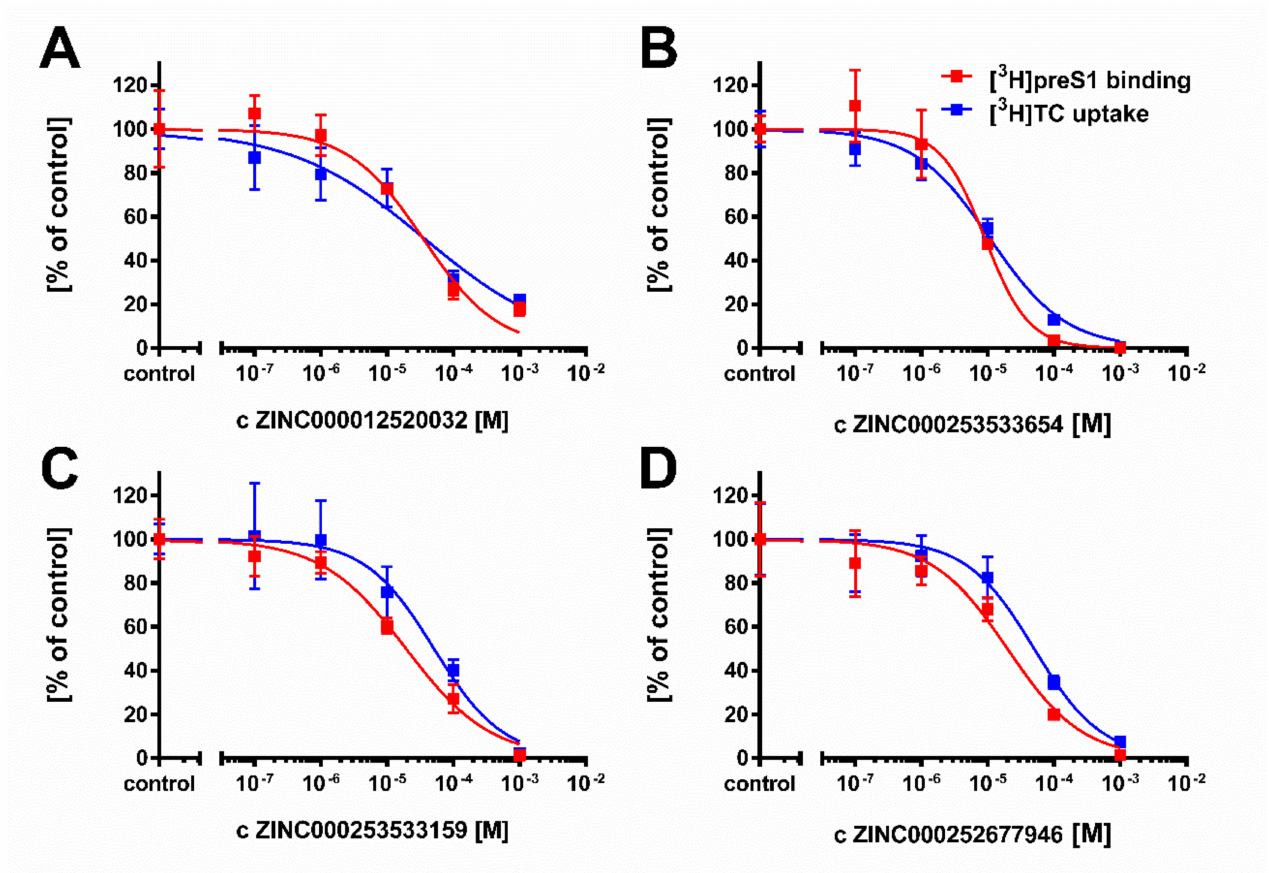
Figure 7. Determination of IC 50 values of selected compounds for inhibition of [ 3 H]preS1 peptide binding to NTCP and [ 3 H]TC transport via NTCP at increasing inhibitor concentrations. ( A ) Substance ZINC000012520032, ( B ) Substance ZINC000253533654, ( C ) Substance ZINC000253533159; ( D ) Substance ZINC000252677946. NTCP-HEK293 cells were seeded onto 96-well plates and were incubated with tetracycline to induce expression of NTCP. Cells without tetracycline treatment were used as 0% controls for both assays. Bile acid transport experiments were performed with 1 µ M [ 3 H]TC and binding experiments were performed with 5 nM [ 3 H]preS1-peptide. Both assays were performed over 10 min at 37 ◦ C with increasing concentrations of the indicated inhibitors. Control experiments were performed with solvent alone (set to 100%). The mean of the 0% control was subtracted to calculate net [ 3 H]TC transport rates (shown in blue) as well as net [ 3 H]preS1 binding rates (shown in red), which are expressed as % of control at the y -axis. IC 50 values were calculated by nonlinear regression analysis using the equation log(inhibitor) vs. response (GraphPad Prism). Data represent means ± SD of quadruplicate determinations of representative